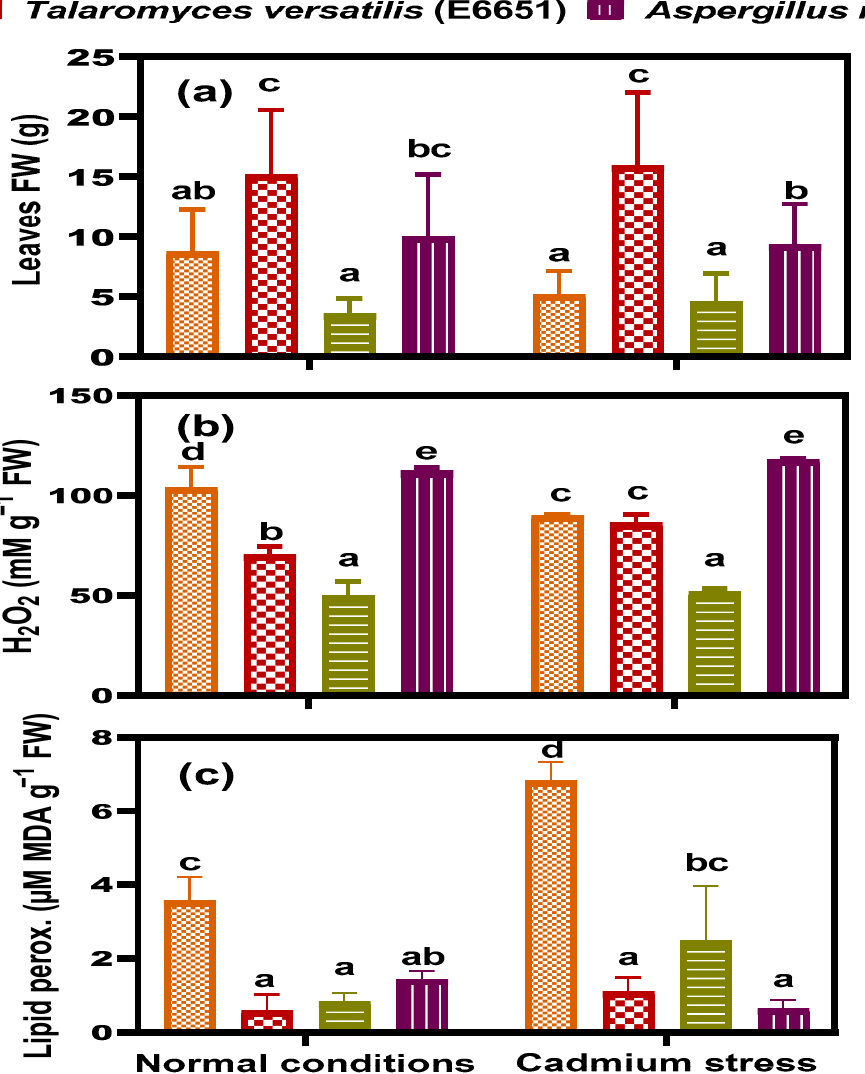
Figure 1. ( a ) Total leaves fresh weight, ( b ) content of H 2 O 2 and ( c ) lipid peroxidation (MDA) of geranium non-inoculated (NI) or inoculated with different endophytic fungi; T . versatilis (E6651), E . nidulans (E6658) and A . niger (E6657) under normal conditions and Cd-stress; after 17 days of applying stress. Values are expressed as means ± SE ( n = 5–8) for ( a ) and ( n = 3) for ( b ) and ( c ). For comparison among different treatments within and between levels of both normal conditions and cadmium stress, values with at least one similar letter are non significantly different according to One-way ANOVA with Post Hoc-Tukey HSD test ( p ≤ 0.05).